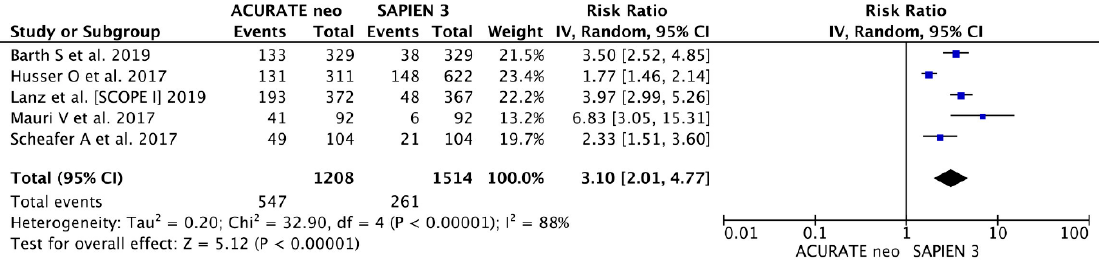
Figure A2. Procedural outcomes. Individual and summary risk ratios with corresponding 95% confidence intervals for the comparison of ACURATE neo vs. SAPIEN 3 in the analysis of postdilatation.